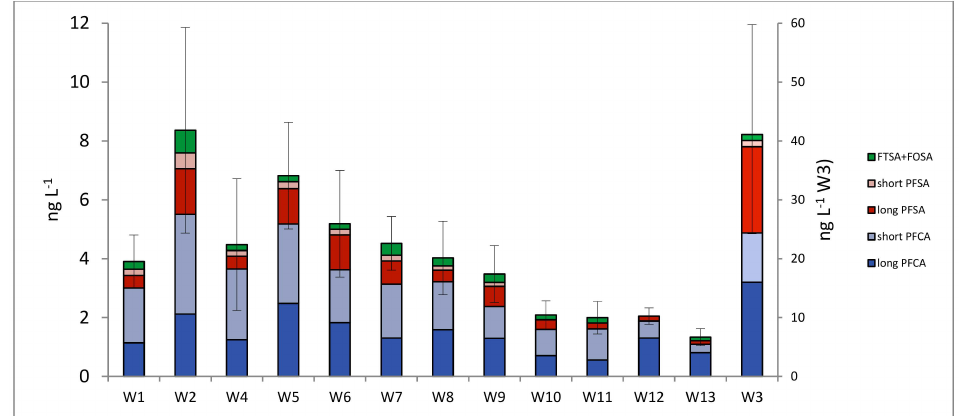
Figure 3. Mean concentrations of PFASs in surface waters and standard deviation of mean total sum of PFASs. Note that for W3, the y-axis is on the